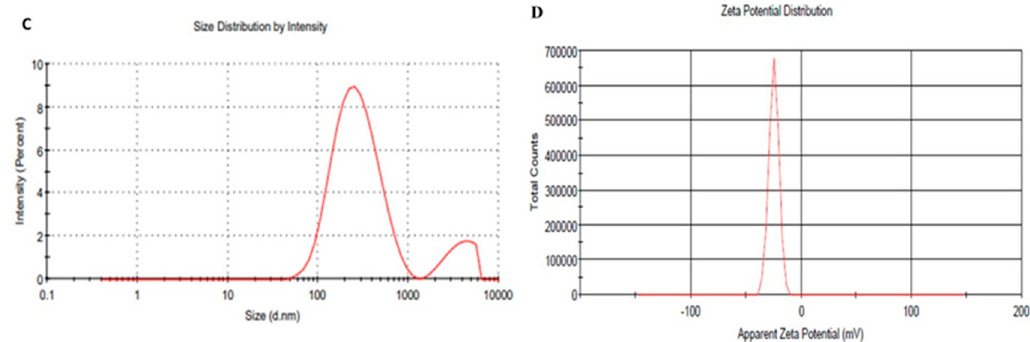
Figure 7. ( A ) Particle size of optimized PEG ‐ NE; ( B ) Zeta potential of optimized PEG ‐ NE ( C ) Particle size of naked ‐ NE; ( D ) Zeta potential of naked ‐ NE.